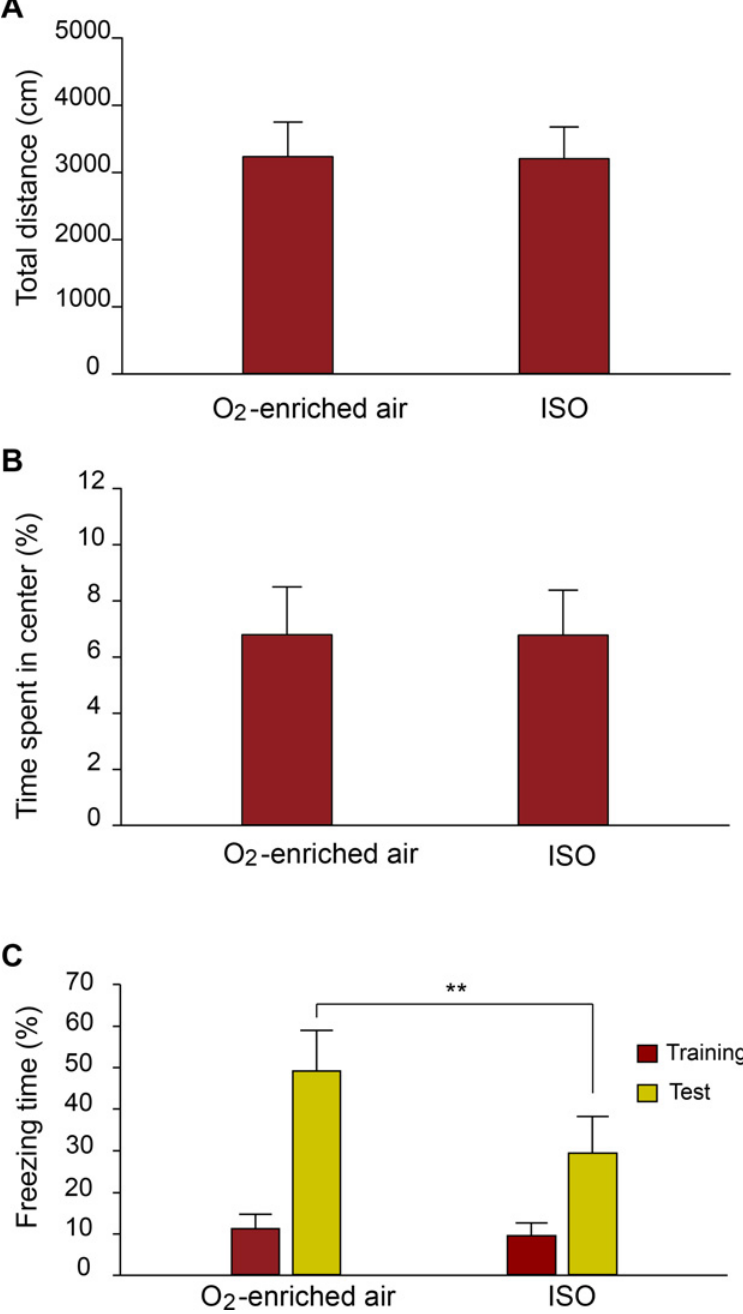
Fig 1. Effect of repeated neonatal isoflurane exposure on behavioral testing. (A) Mice that received repeated neonatal exposure to 0.75% isoflurane displayed normal traveled total distance in Open-field tests. (B) Mice that received repeated neonatal exposure to 0.75% isoflurane displayed normal affective state (anxiety level), which was measured by the percentage of time spent in the center of open-field. (C) Mice that received repeated neonatal exposure to 0.75% isoflurane displayed decreased freezing time ( ** p < 0.01 versus control) during contexual fear conditioning (CFC) test. The control group inhaled 30% O 2 -enriched air during the neonatal